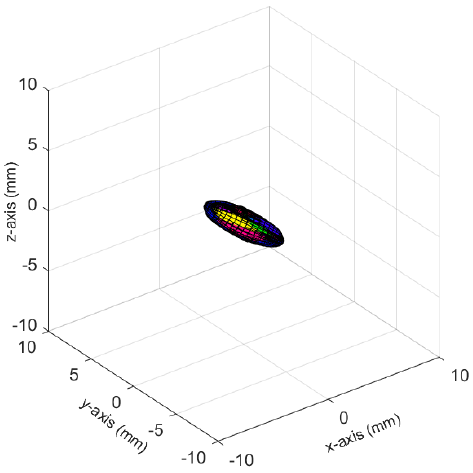
Figure 7. Ellipsoids of the joint position of the PELVIS for processing mode CUDA (Figures for all processing modes are shown in Figure A3). The different colors represent different body tracking runs.